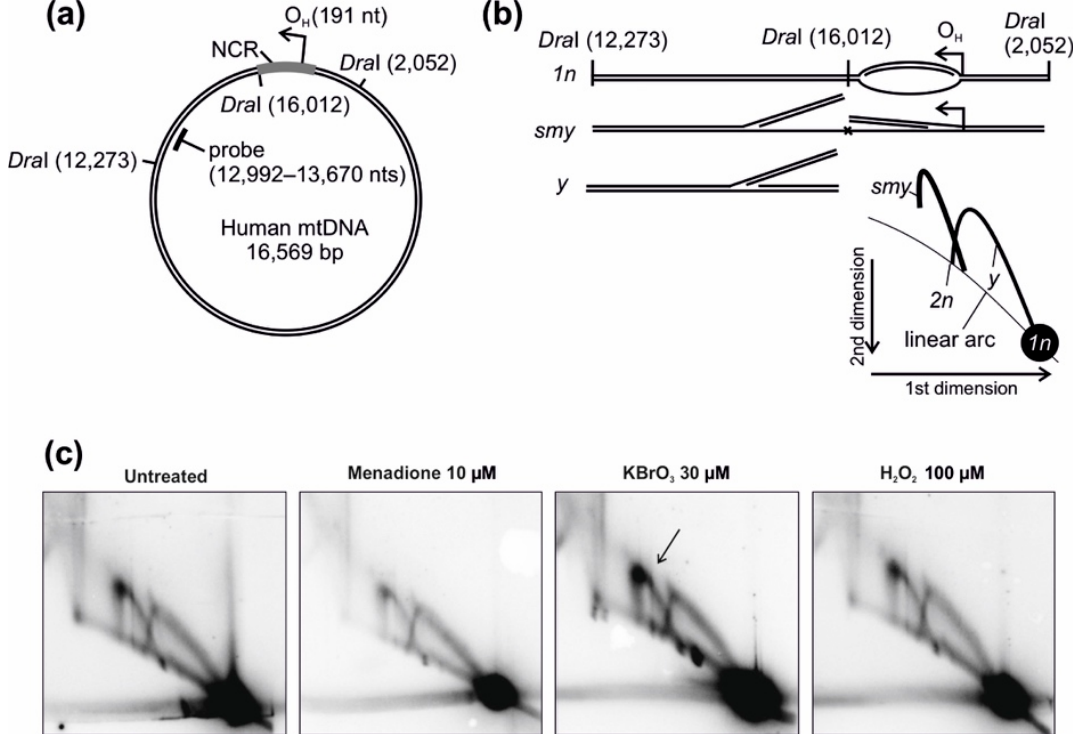
Figure 6. Modulation of mitochondrial DNA replication during oxidant exposure. ( a ) Schematic diagram of human mtDNA showing the investigated genomic region. ( b ) Interpretation of the 2D-AGE pattern. The probed fragment is downstream of the main replication origin O H . Restriction site blockage due to single-strandedness or RNA incorporation on the lagging strand will give rise to slow moving y-arc (smy) whereas double-stranded DNA replication intermediates migrate the y-arc (y). ( c ) 2D-AGE of DraI-digested mtDNA from untreated control cells, cells treated with 10 μ M menadione, cells treated with 30 μ M KBrO 3 , and from cells treated with 100 μ M H 2 O 2 for 24 h. Arrowhead points to the increase in the partly single-stranded mtDNA replication intermediates in KBrO 3 -treated cells (see [15,16] for more details).